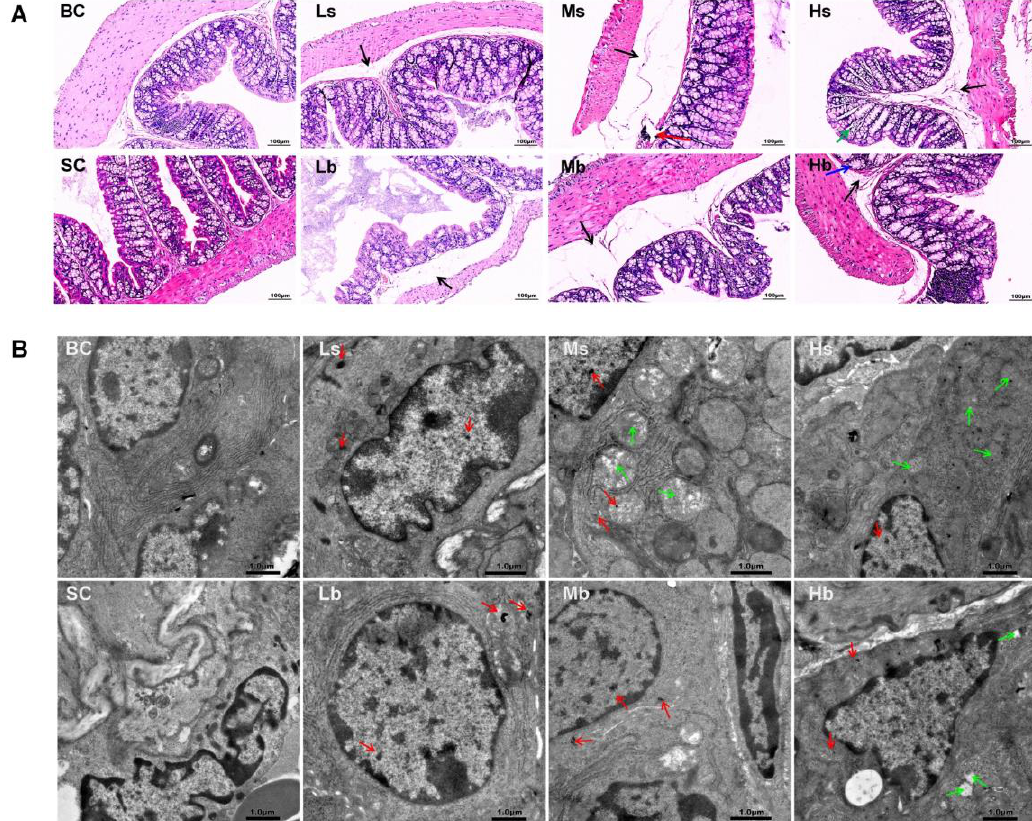
Figure 2. Effects of exposure to PP-MPs on colonic histopathology and ultrastructure in mice. ( A ) Images of H&E-stained colon sections of mice treated with PP-MPs. Black arrow: submucosal edema; red arrow: massive aggregation of lymphocytes; blue arrow: glandular hyperplasia of mucosal layer; green arrow: inflammatory cell infiltration. ( B ) Ultrastructural changes of colon after exposure to PP-MPs. Red arrows: PP particles; green arrow: slight abnormality of mitochondrial structure, with loose ridge arrangement, less matrix, partial swelling, and vacuolation. n = 3. BC: blank control (pure water); SC: solvent control (pure water containing 0.01% v / v Tween-80); PP-MPs: polypropylene microplastics. Ls: 8 μm PP at 0.1 mg/mL; Ms: 8 μm PP at 1.0 mg/mL; Hs: 8 μm PP at 10 mg/mL; Lb: 70 μm PP at 0.1 mg/mL; Mb: 70 μm PP at 1.0 mg/mL; Hb: 70 μm PP at 10 mg/mL. scale bar = 1 μm .